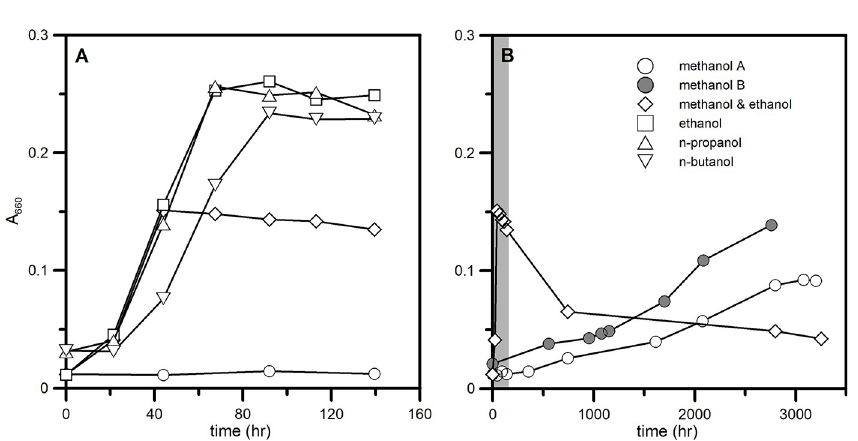
Fig 1. Growth of D . carbinolicus on various alcohols as electron donors in batch cultures. A shaded interval in (B) indicates the first 160 hours of the batch culture experiments (A). Methanol A represents the methanol batch culture inoculated with ethanol-grown cells, while methanol B indicates a second-generation culture inoculated with methanol A.